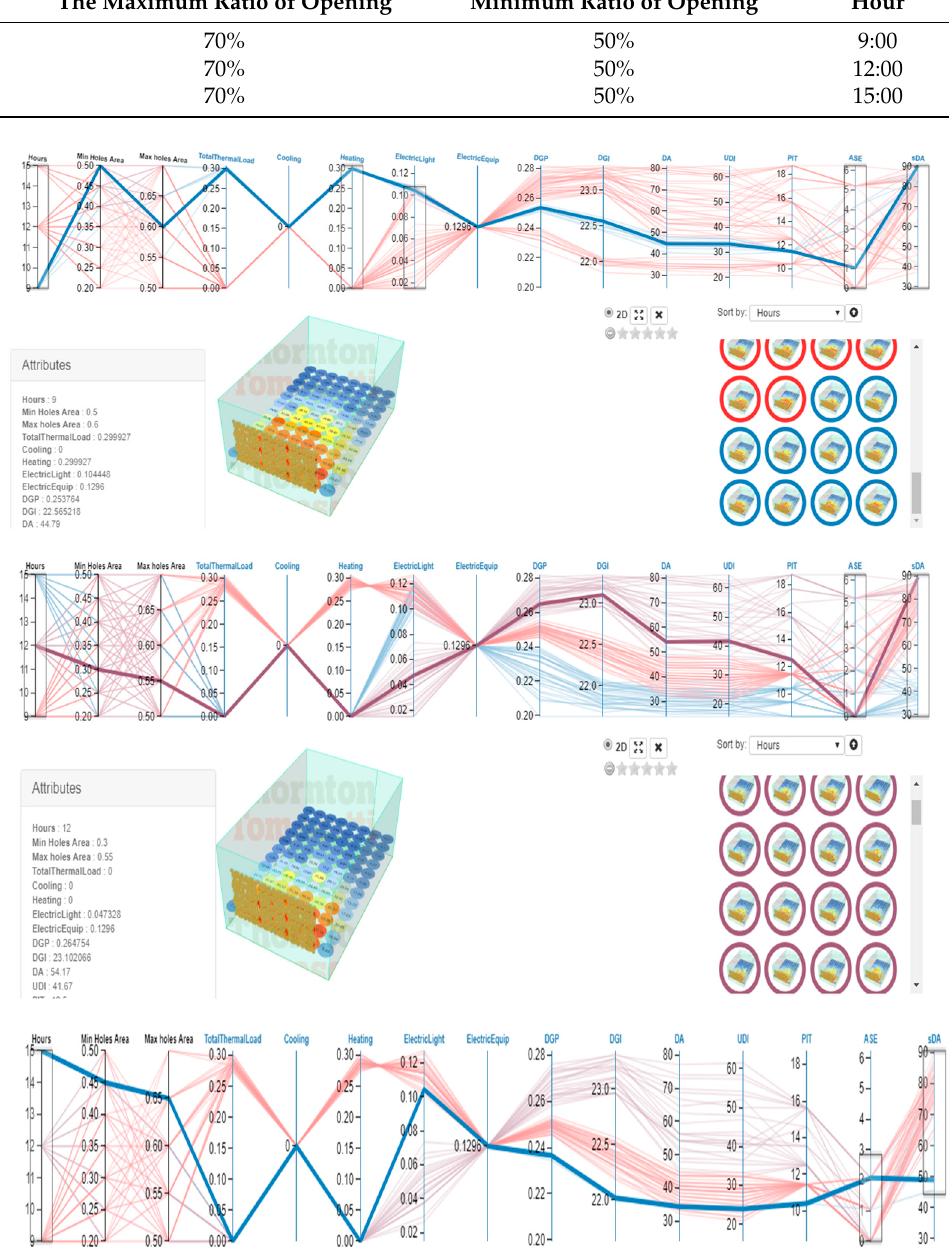
Figure 24. Choosing the optimal conditions for different hours on December 21st.